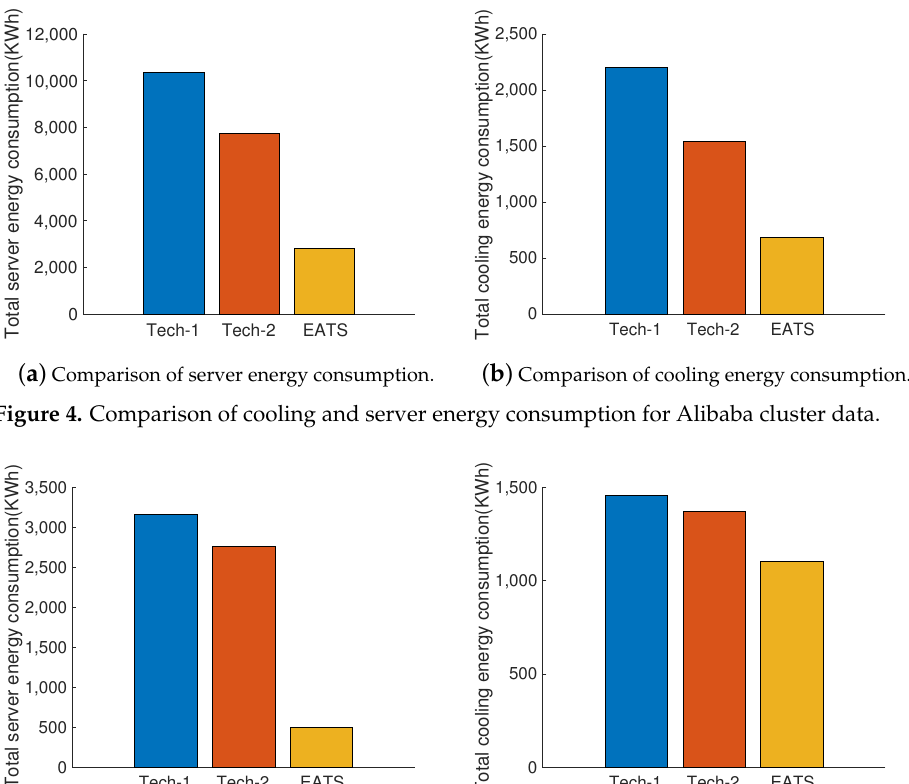
( b ) Comparison results of the cooling system energy consumption. Figure 5. Comparison of cooling and server energy consumption for Google cluster